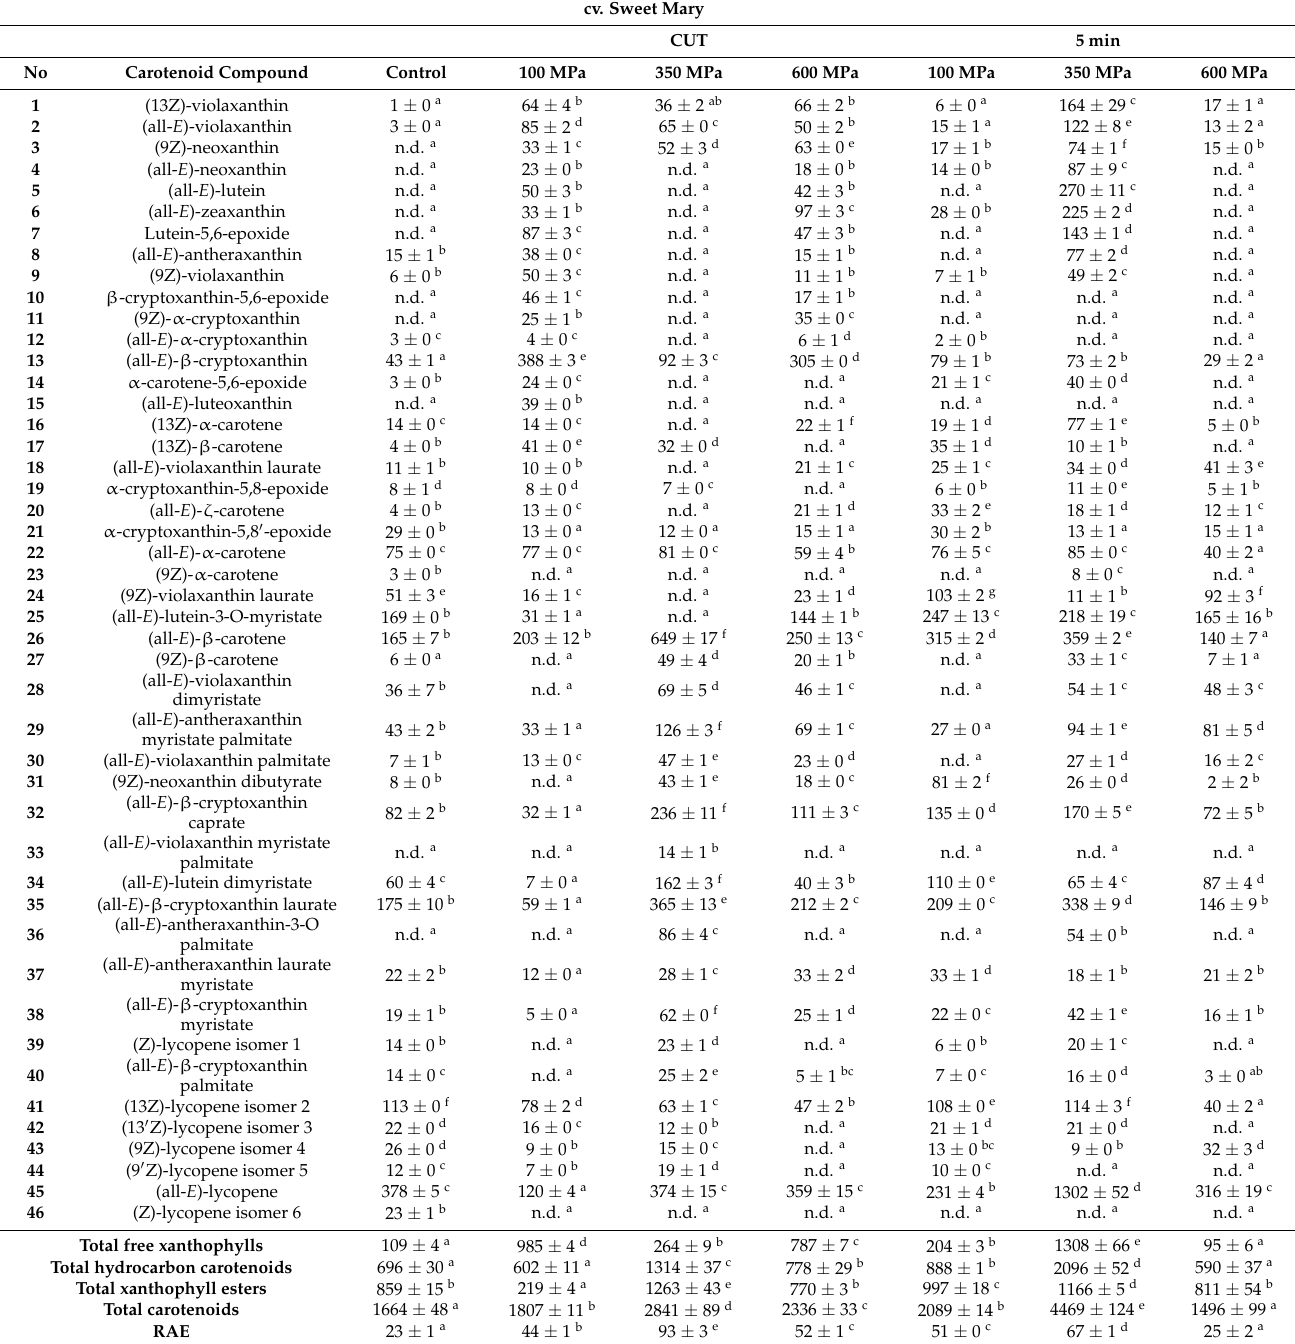
Table 1. Carotenoid content ( µ g/100 g fresh weight) and retinol activity equivalents (RAE) of direct pulp extracts of papaya ( Carica papaya L.) Sweet Mary variety submitted to